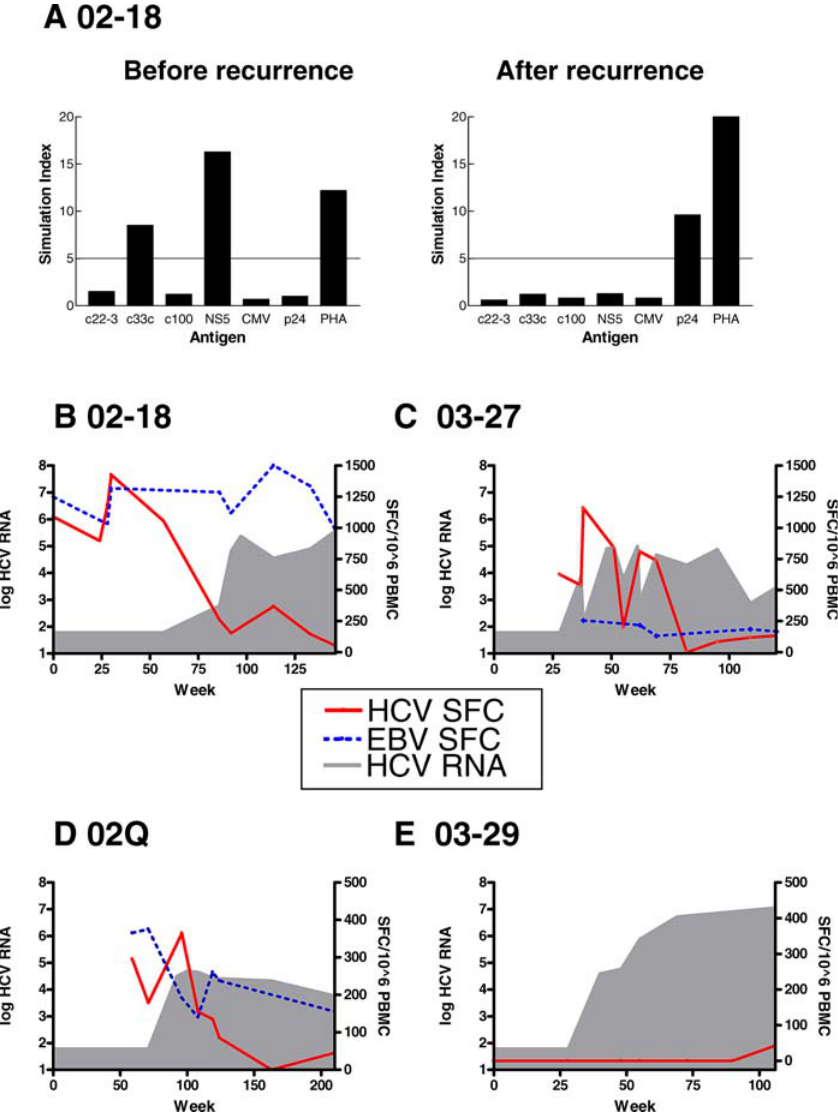
Figure 7. HCV-Specific T Cell Responses before and after HCV Recurrence in HIV þ Participants with Prior Spontaneous Control (A) LP responses before and after HCV recurrence. Responses to c33c (NS3) and NS5 declined after the establishment of viremia. By contrast, stimulation indices to HIV-1 p24 antigen and phytohemagglutinin (positive control) increased. (B–E) The degree of viremia is shown in shaded gray for four participants. IFN- c measurements are in spot-forming cell (SFC)/10 6 PBMCs. The cumulative HCV CD8 þ T cell response is represented by the solid red lines. In three participants who demonstrated decline in HCV-specific CD8 þ T cell